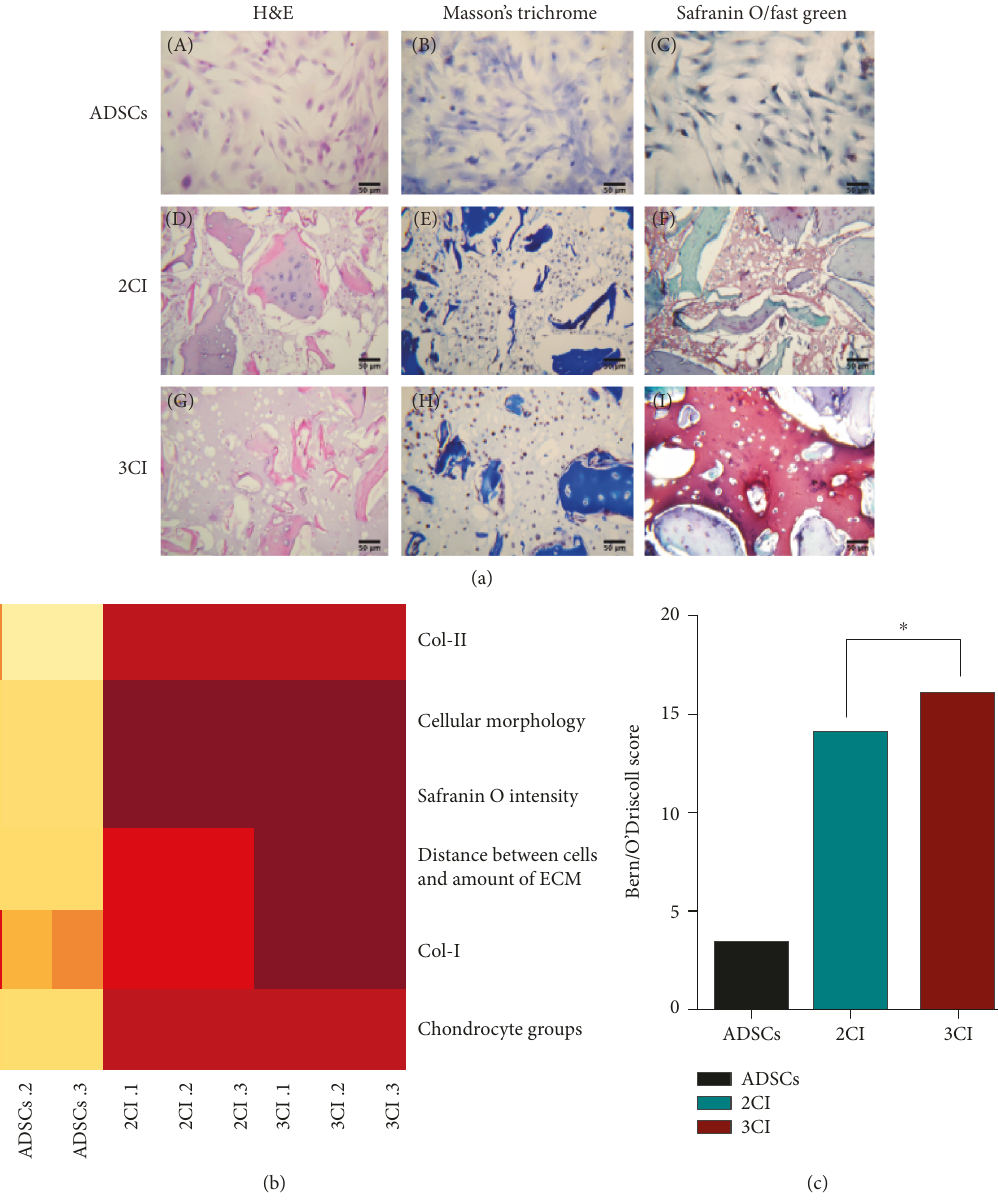
Figure 7: Histological evaluation of the 3CI and 2CI implants by the Bern/O ’ Driscoll scale. (a) Histological evaluation of 2CI and 3CI groups after 28 days of culture. (A – C) Adipose-derived mesenchymal stem cells cultured in a monolayer as a negative control. 2CI and 3CI showed the typical rounded morphology of chondrocytes (D, G), as well as strongly positive staining of bovine cartilage fragments for Masson ’ s trichrome, and also exhibited neomatrix formation with chondrocyte-like appearances (E, H). Interestingly, sections stained with safranin O to detect proteoglycan (in red) (F, I) show for 3CI a dense neomatrix formation that is strongly stained (I) (scale bar: 50 μ m). (b) Heat map generated by unsupervised clustering analysis programming in R. The intensity of color varies according to a given value criterion, and similar color patterns are grouped together. Strong colors (red) show a greater similarity to the natural cartilage tissue. (c) Histological analysis by the Bern/O ’ Driscoll score. The summation of parameters evaluated for each experimental group show that 3CI was more similar to natural cartilage tissue in comparison with 2CI ( ∗ p < 0 05 ) as evidenced by the Wilcoxon test for nonparametric